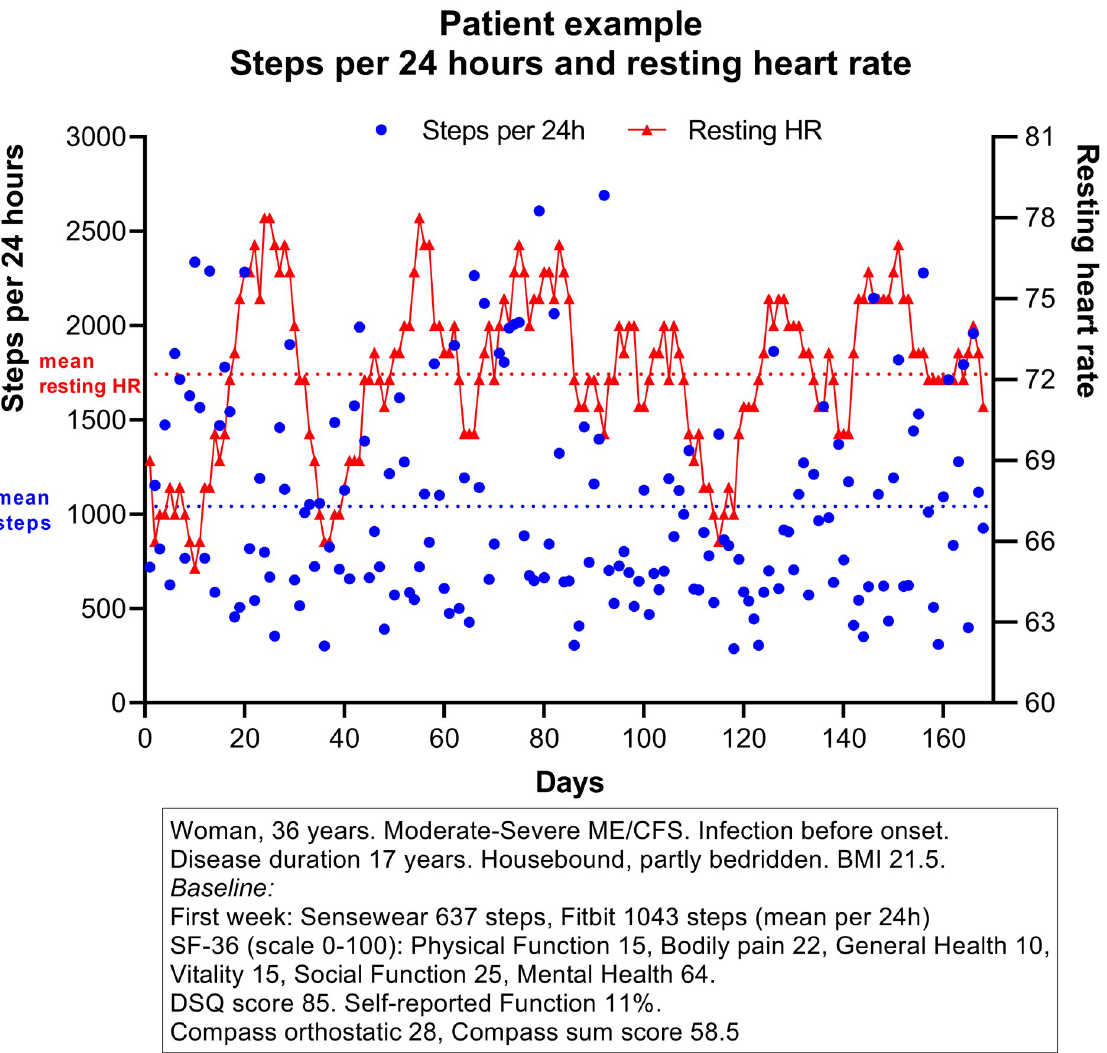
Fig 2. Patient example. Patient example with raw data for steps per 24 hours and resting heart rate, days 1–168.